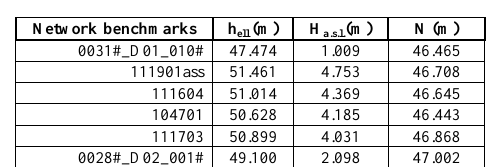
Table 7: Geoid undulation assessed by grid-derived orthometric